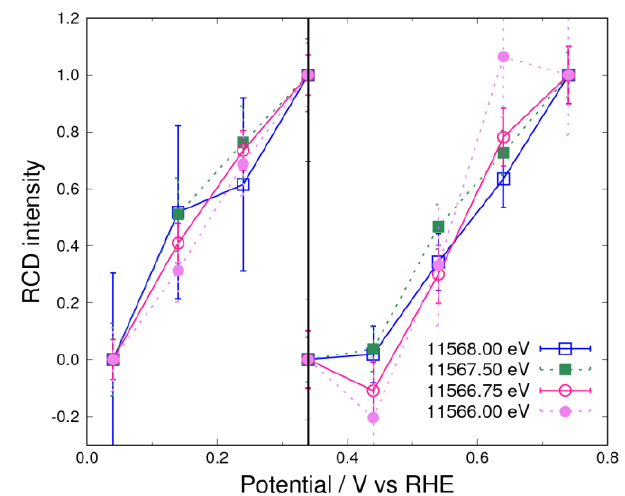
Figure 5. Rate of change of the ∆ µ (RCD) curves for the controlled potential below 0.74 V in 1 M of KOH saturated with N 2 . The standard potentials are 0.04 V, 0.34 V, and 0.74 V. The circle and square curves represent the negative and positive peak of 11,566.75 eV and 11,567.5 eV, respectively. The dashed lines complement the explanation for RCD.